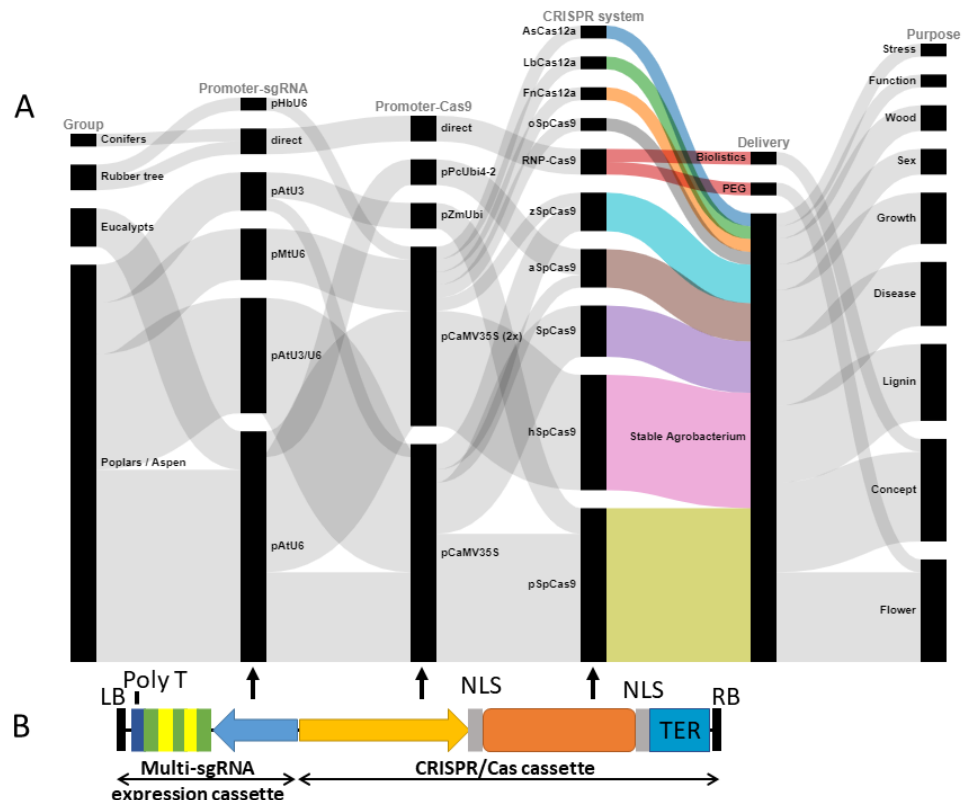
Figure 2. Overview of the constructed CRISPR/Cas systems that are used in genome editing of